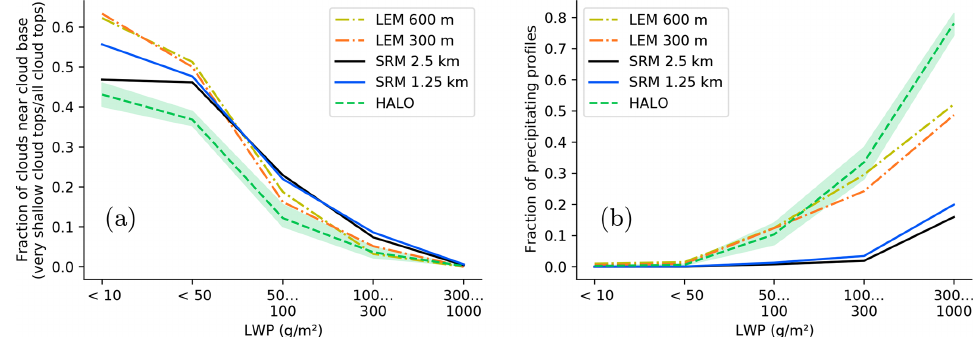
Figure 8. Fraction of very shallow clouds and precipitating clouds as a function of LWP. (a) Fraction of clouds near cloud base defined as ratio of very shallow clouds (lidar-detectable cloud top within LCL and LCL + 600m) to all shallow clouds (lidar-detectable cloud top height < 4000m). (b) Fraction of precipitating profiles defined as the ratio of radar echo below LCL to all profiles. Shading of the HALO dataset represents the uncertainty of the LWP